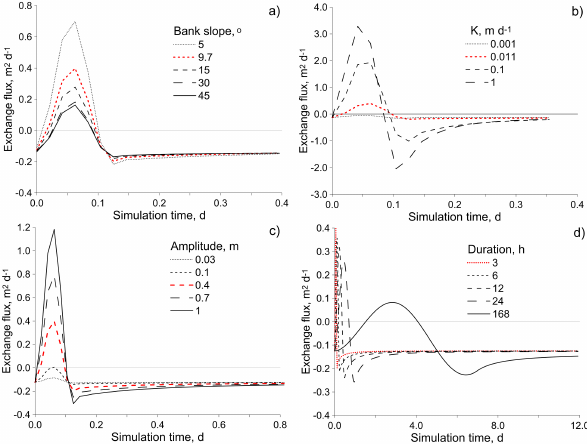
Figure 6. Exchange flux for different bank slope (a) , hydraulic con- ductivity (b) , wave amplitude (c) and duration (d) scenarios, with the reference case (red) and insets of the input wave pulse. Note different scale.